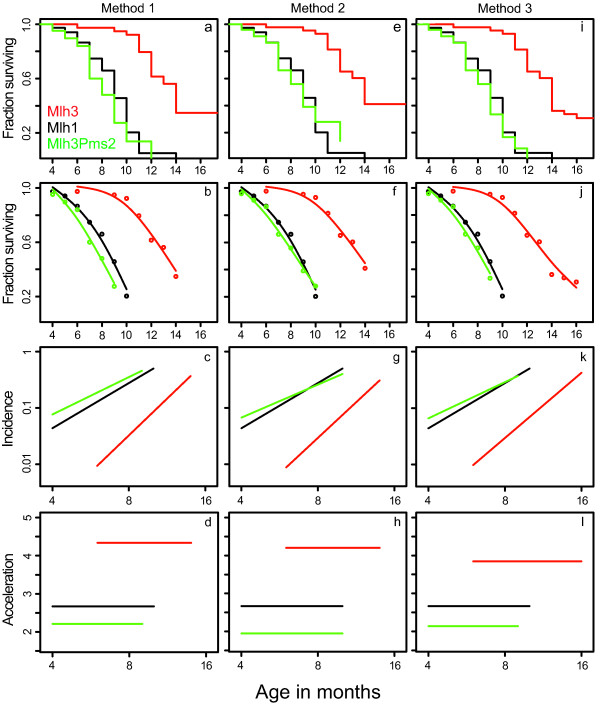
GI tumor kinetics for three MMR knockout mouse genotypes. For each genotype, both alleles at each locus were knocked out. a Kaplan-Meier estimate [2] at each age of the fraction of mice that have not yet developed GI tumors among the population of mice that remain at risk. b Smoothed curve fit to the estimated survival curve in a using the smooth.spline function of the R computing language [2] with the smoothing parameter set to 0.5. c Incidence of GI tumors on log-log scales. d The acceleration of tumor onset calculated from the slope of the lines in c. Each column of plots corresponds to one of the three methods for dealing with the 7 observed GI carcinomas; we explained the different methods in the text. In our calculations, we truncated the curves at survival fractions below 0.2 because the errors in incidence estimates rise rapidly at low levels of survival. The spreadsheet included in the supplemental materials provides a full listing of the data used to generate Figures 1 and 2.